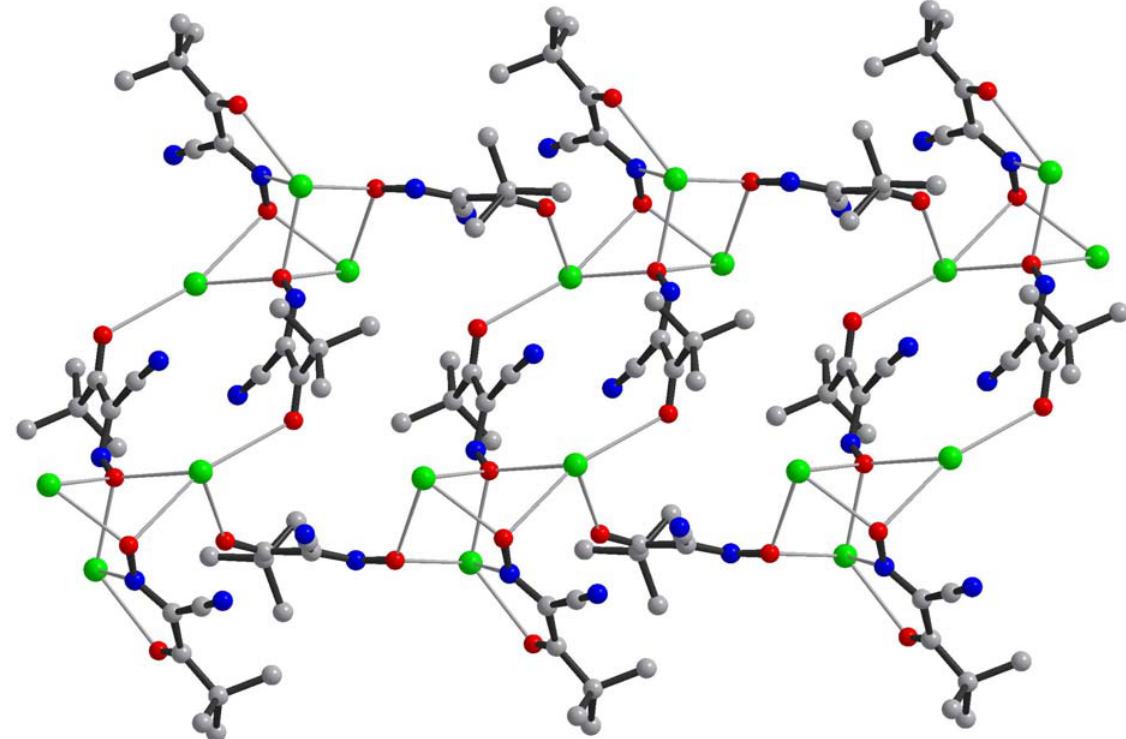
Figure 8. Organization of a complex, unique 2D-coordination polymeric sheets in the structure of Tl(PiCO). H-atoms are omitted for clarity.